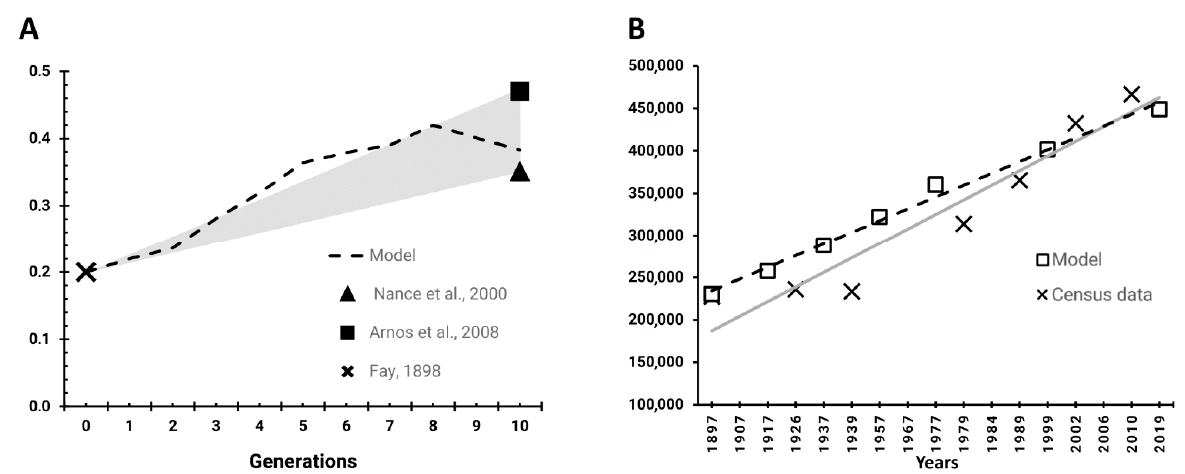
Figure 2. Model validation and verification. ( A ) Comparison of model outcome with archive data for the USA deaf population. Increase in the proportion of recessive mutant homozygotes in the model outcome (dotted line with diamonds—10 data points) was comparable to the data reported by Nance et al. [23] and Arnos et al. [25]. ( B ) Comparison of model outcome with archive census data on the Yakut population. The trend of population size increase in the model outcome (black dashed line with squares) was comparable to the actual growth of the Yakut population according to census data (grey solid line with crosses).